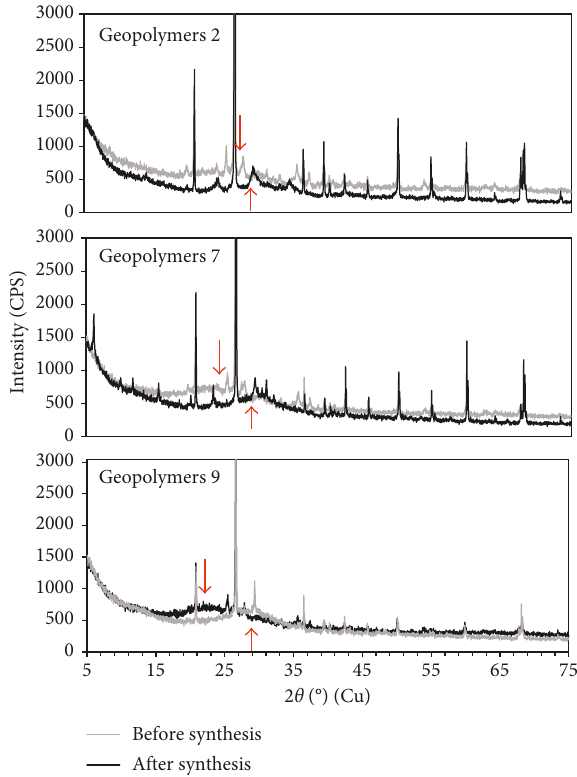
Figure 3: XRD of geopolymers 2, 7, and 9 before and after